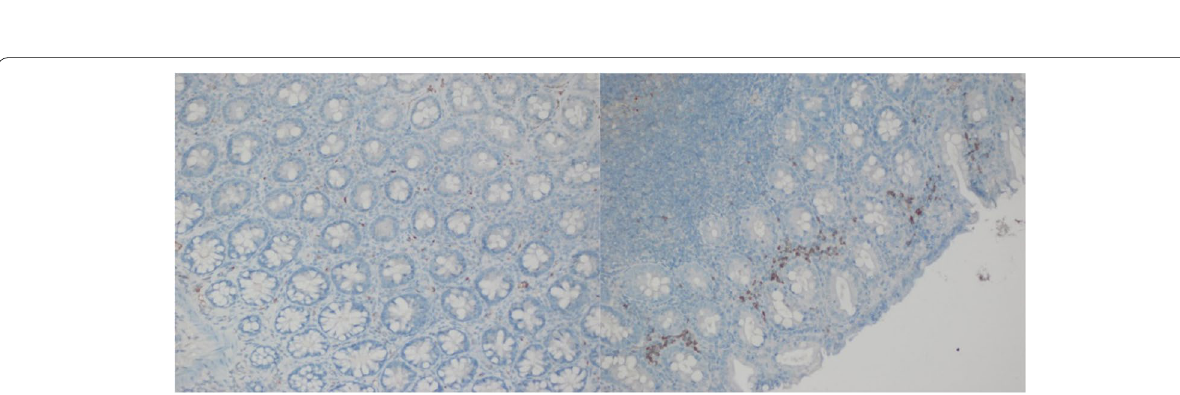
Fig. 3 IL-6 antibody, 20. Expression in clustered cells in the lamina propria was expressed as × evaluated